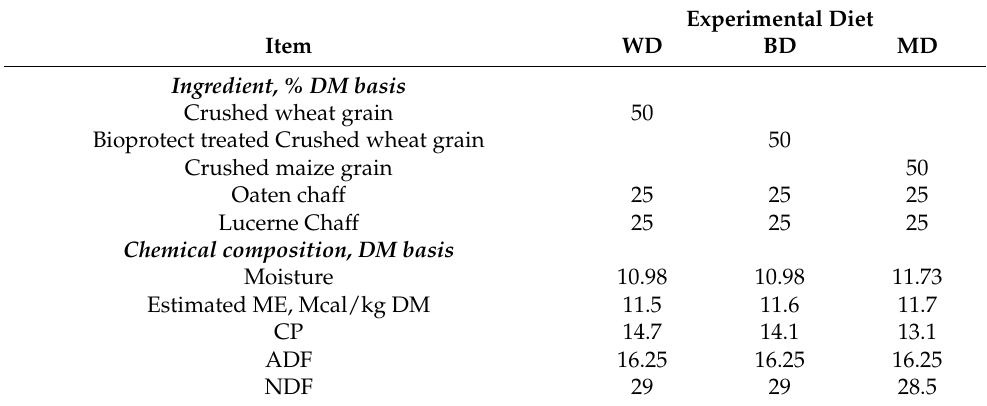
Table 1. Ingredient and chemical composition of experimental diets offered to Lambs on a DM